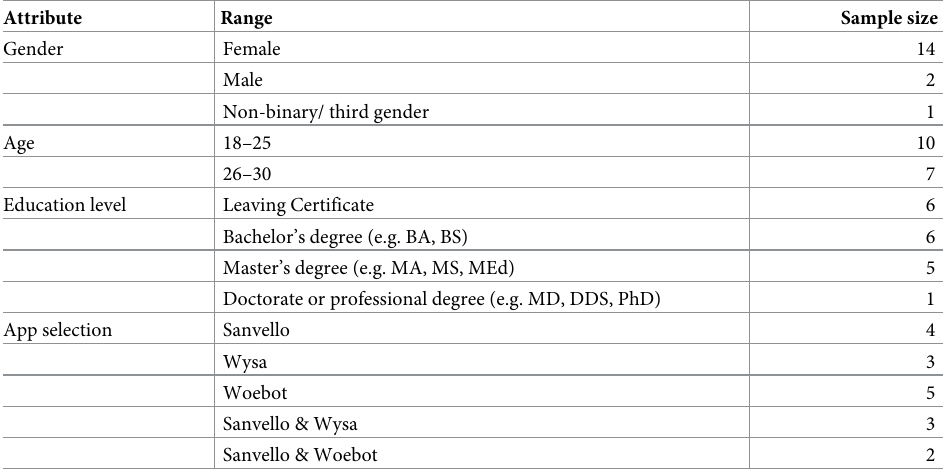
Table 1. Demographic characteristics & App selection of study